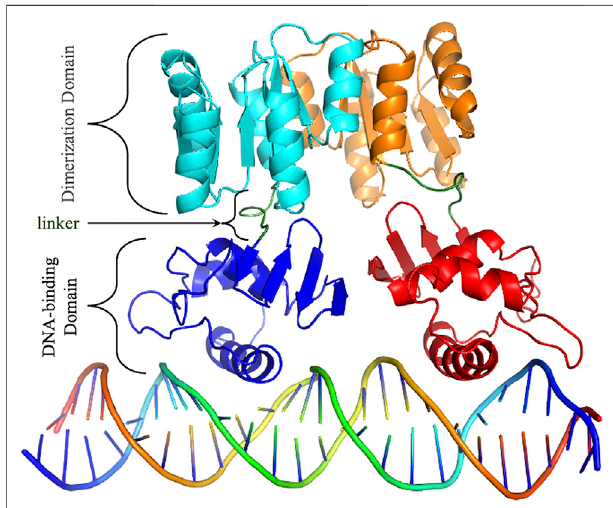
FIGURE1| HP1043 structure.Cartoonrepresentation ofHP1043bond to the DNA model. Protein domains and linker are